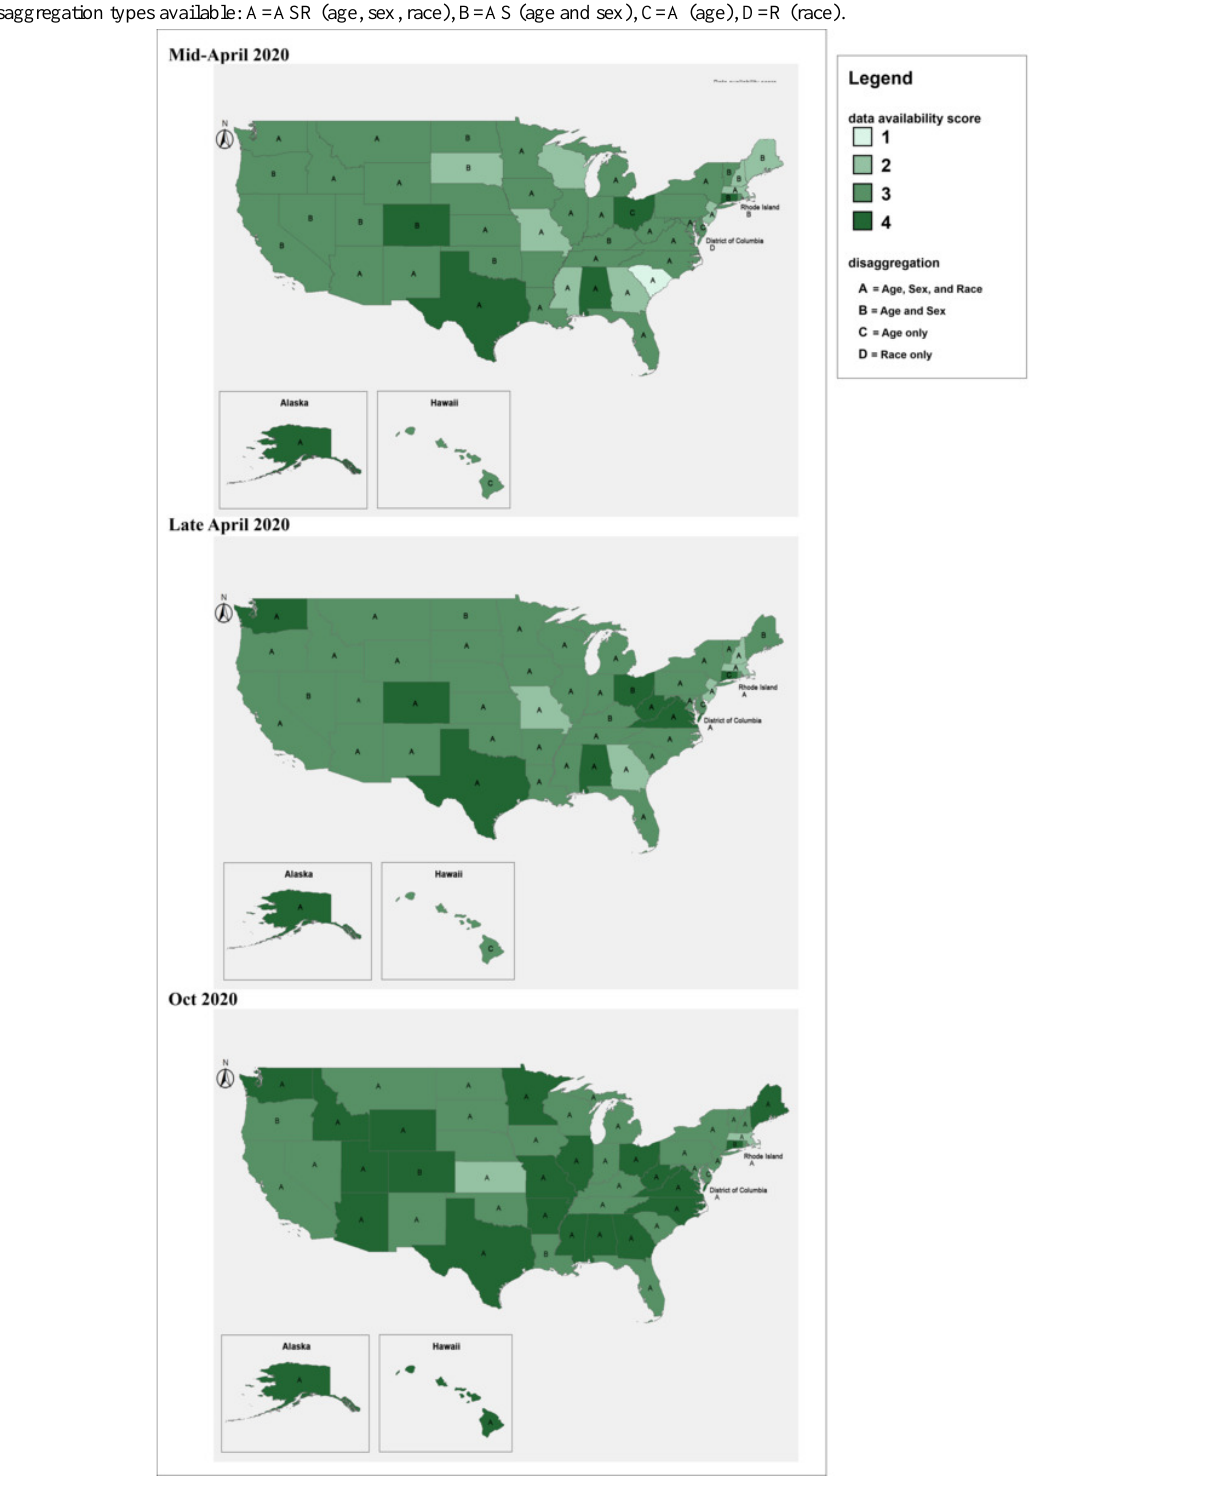
Figure 1. Demographic COVID-19 data reported by state public health departments of the Unites States (A) before, (B) immediately after, and (C) 6 months after the introduction of the Equitable Data Collection and Disclosure on COVID-19 Act. Data availability scores: 1=totals only (confirmed cases and deaths in the state); 2=figures or web tables showing disaggregation of any kind; 3=interactive dashboards; and 4=machine-actionable data. Disaggregation types available: A=ASR (age, sex, race), B=AS (age and sex), C=A (age), D=R